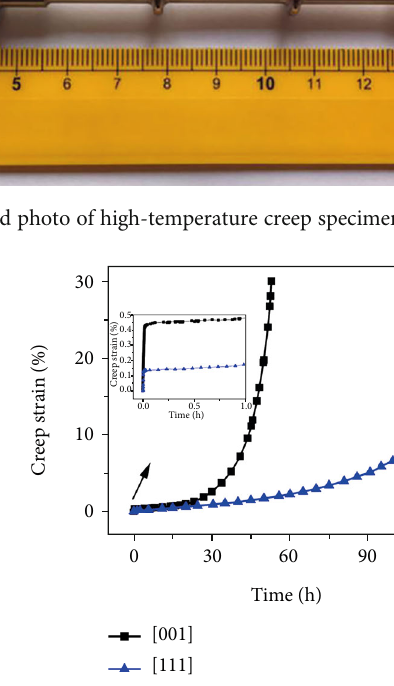
Figure 2: Creep curves of the single crystal alloy IC6SX with [001] and [111] orientations at 850 °